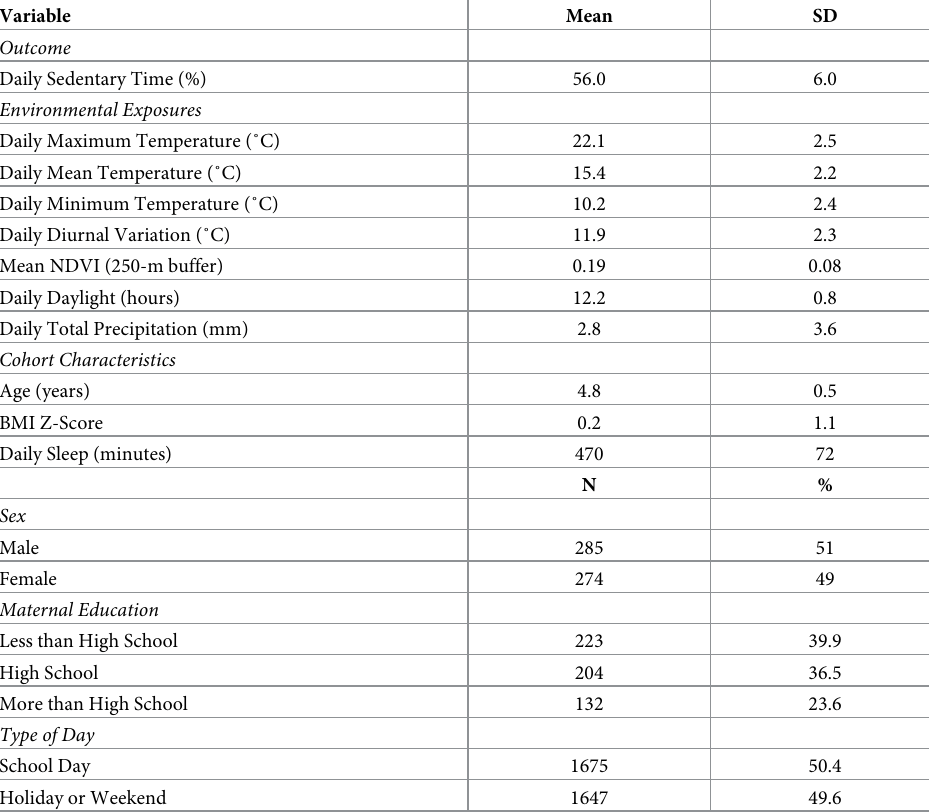
Table 1. Summary